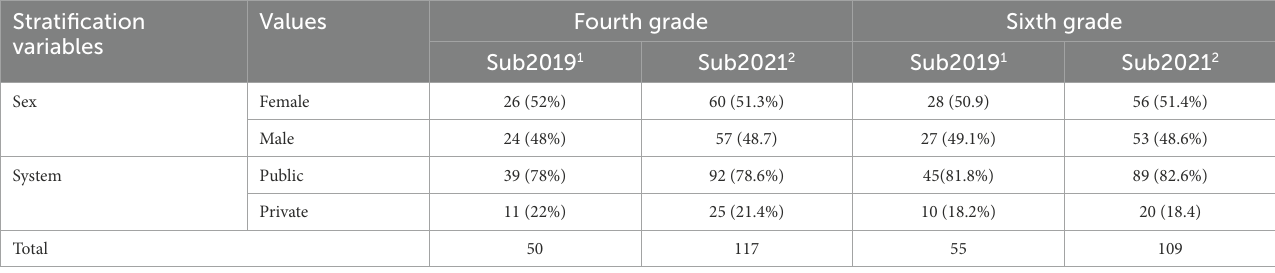
TABLE 2 Stratification of the samples to obtain their